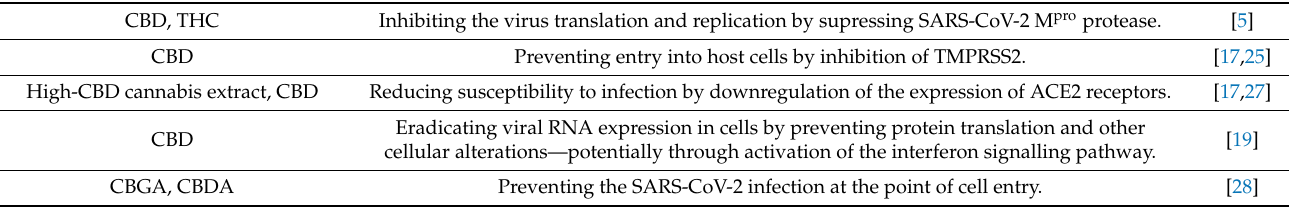
Table 1. The antiviral properties of phytocannabinoids. CBD, THC Inhibiting the virus translation and replication by supressing SARS-CoV-2 M pro